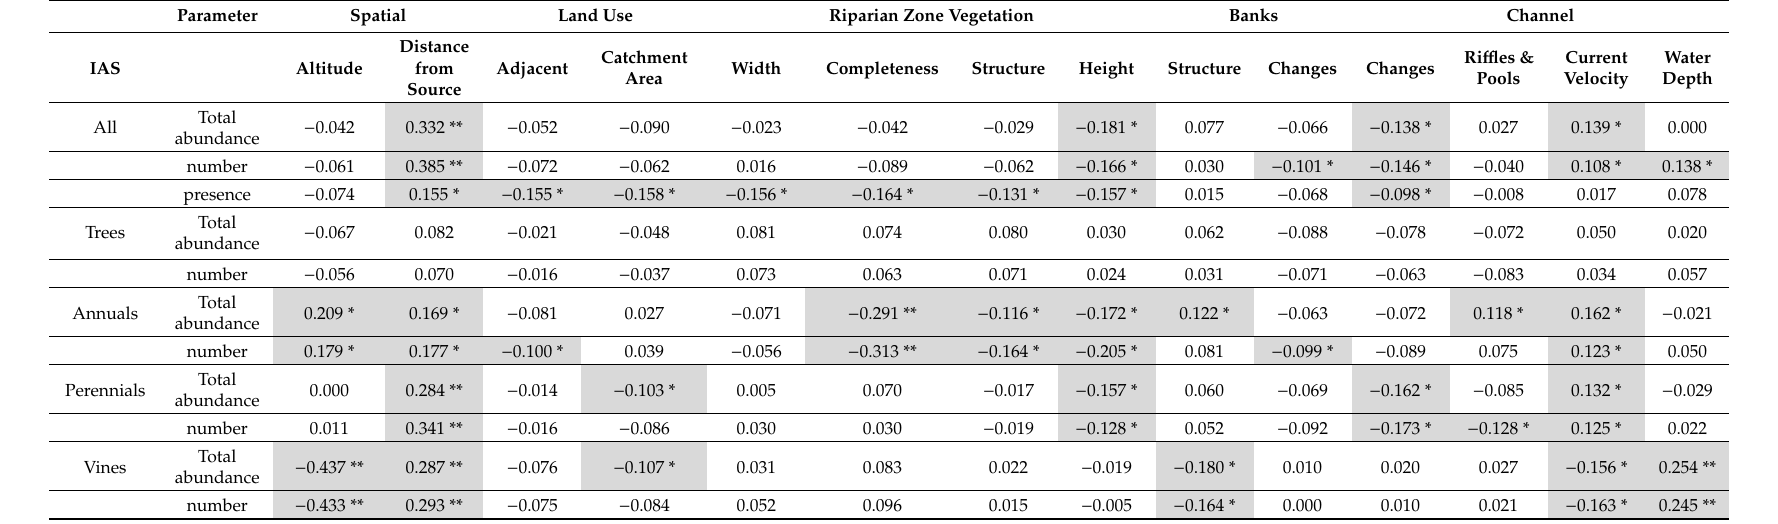
Table 2. Spearman correlation coe ffi cients for the relationships between the environmental factors and the IAS parameters and their growth forms. Shaded fields contain statistically significant correlation coe ffi cients (* at p < 0.05; ** at p <